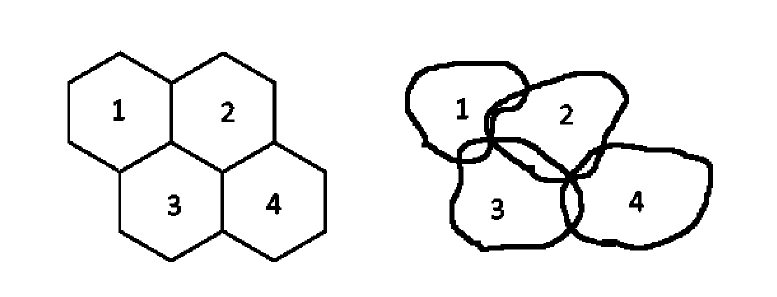
Figure 1. In the left, theoretical coverage; on the right, a real coverage